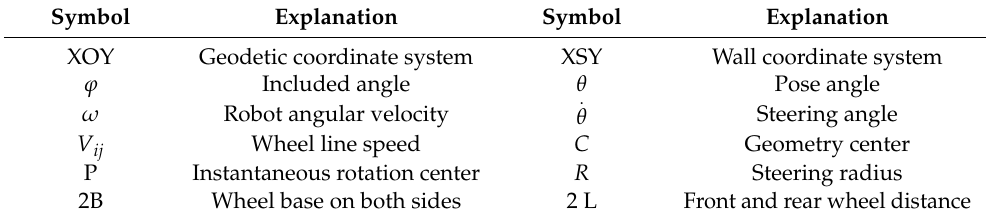
Table 1. Parameter symbol description